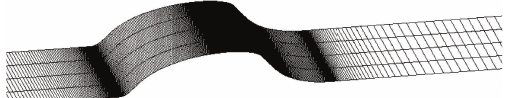
Figure 4: Surface grid for 3D unsteady cases (note: 5 spanwise planes are shown).